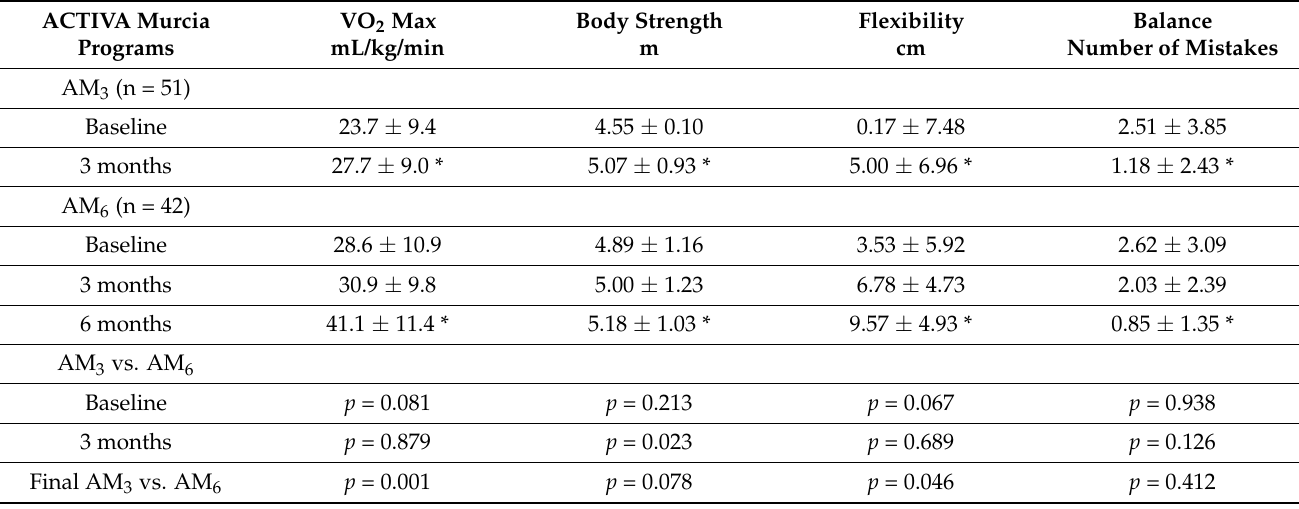
Table 3. Differences in physical condition at different time points between the two community-based exercise